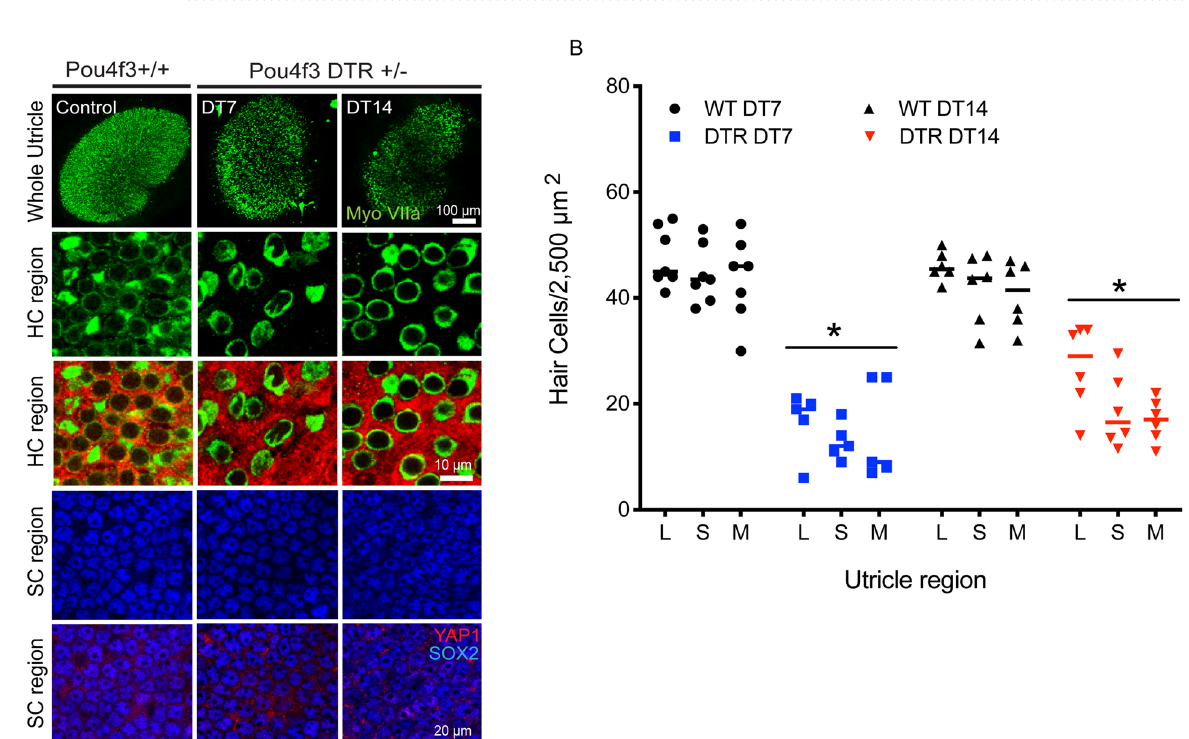
Figure 3. Transient nuclear translocation of YAP1 in organotypic culture of the mouse utricle. ( A ) Utricles were explanted from CD1 mice at P15, and attached to Matrigel-coated dishes. Specimens were fixed and examined after 0–24 h in culture. Confocal images show supporting cells of cultured utricles immunolabeled for YAP1 (red) and SOX2 (blue). ( B ) Utricles were explanted at P15 and cultured in a Matrigel-coated or uncoated dishes as free-floating samples. Cultures were fixed and examined after 2 and 6 h in vitro. Confocal images show supporting cells of cultured utricles immunolabeled for YAP1 (red) and SOX2 (blue). ( C ) Quantitative data on the percentage of supporting cells with nuclear YAP1 immunoreactivity. All data were obtained from 10,000 µm 2 regions within the extrastriolar and striolar regions of each utricle. There was a significant increase in nuclear YAP1 immunolabeling at 2 h, 6 h and 12 h in vitro, relative to specimens fixed immediately after explantation (0 h) (p < 0.0001, 12 h, Ex-striolar p = 0.0027, Striolar p = 0.0198). ( D ) Quantitative data on the percentage of supporting cells with YAP1-labeled nuclei. All data were obtained from 10,000 µm 2 regions within the extrastriolar and striolar regions of each utricle. There was no significant increase in the percentage of cells with nuclear YAP1 at 2 hr and 6 hr time points between the coated and uncoated cultures. However, there was a significant increase in nuclear YAP1 immunolabeling in utricles cultured in coated and uncoated dishes at the 6 hr time point, vs. those cultured for 2 hr (p < 0.0001). ( E ) Effects of culture in neomycin on YAP1 nuclear immunoreactivity in supporting cells. Images at far left show the lumen of the sensory epithelium in control and neomycin-treated utricles. Culture for 24 h in 3 mM neomycin led to reduced numbers of hair cells (red). Remaining images show z-sections through the sensory epithelia of control and neomycin-treated utricles, at the level of hair cell nuclei (middle images) and supporting cell nuclei (images at right). Each z-section is shown with and without DAPI-labeled nuclei (grey). Regardless of treatment condition, immunoreactivity for YAP1 (green) was primarily confined to the cytoplasm of supporting cells. Data expressed as mean ± SD. Statistical test was one-way ANOVA followed by Bonferroni’s post hoc test (*p value < 0.05) (**p-value < 0.05 for Ex-striolar and Striolar both region). N = 3–6 utricles.